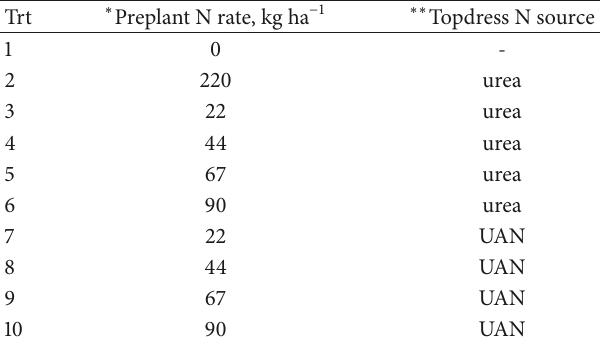
Table 2: Treatment, preplant N rate, and topdress N source for each study site.